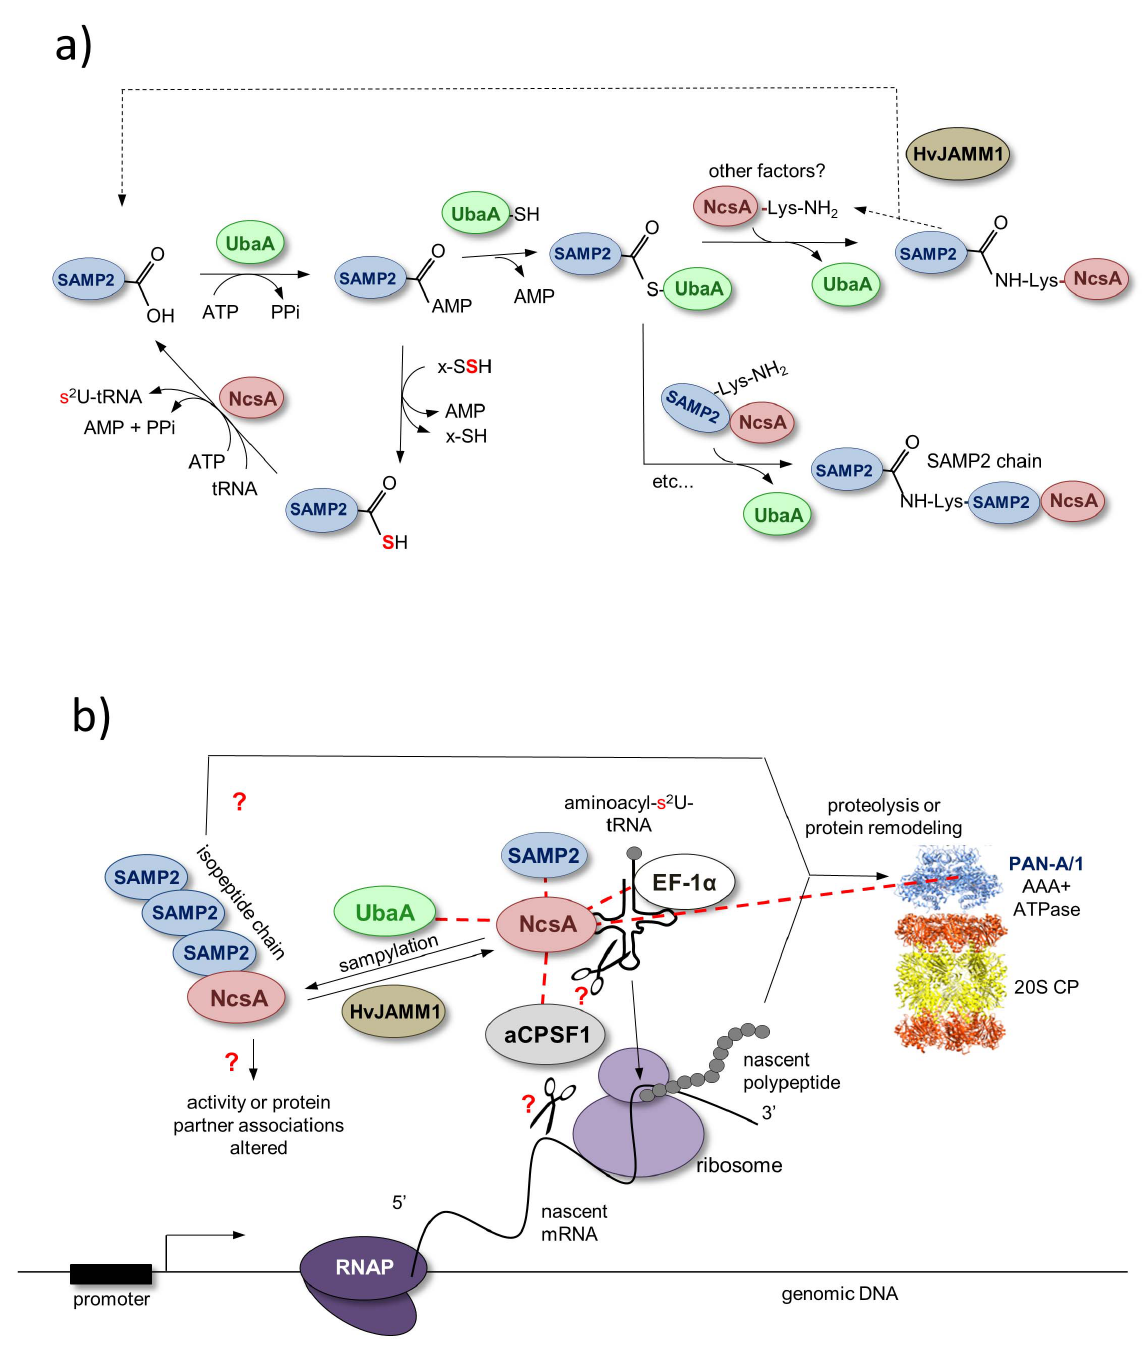
Figure 8. Model of NcsA activity and sampylation (panel A) as well as its association with protein partners (panel B). Panel A, NcsA is proposed to catalyze the formation of 2-thiouridine (s 2 U) at the wobble uridine position of tRNAs specific for lysine (tRNA Lys UUU ), glutamate (tRNA Glu UUC ), and glutamine (tRNA Gln UUG ) via an adenylated tRNA intermediate using thiocarboxylated SAMP2 as a source of activated sulfur. The E1- like UbaA adenylates the C-terminal a -carboxylate group of SAMP2. This modification readies the Ub-fold SAMP2 for either thiocarboxylation via an enzyme (cysteine desulfurase or rhodanese) catalyzed persulfide sulfur or protein modification via formation of a UbaA-SAMP2 thioester intermediate. Polymeric chains of SAMP2 are formed on an NcsA lysine residue via isopeptide linkages that are cleaved by HvJAMM1 protease. Whether additional factors are needed to provide specificity to the sampylation system is unclear, as E2 and E3 homologs are not predicted based on genome sequence. Panel B, NcsA is found isopeptide linked to SAMP2 and non-covalently associated with various proteins, as noted by dotted red lines. NcsA partners include the E1-like UbaA and Ub-fold SAMP2 of the tRNA thiolation and sampylation pathways. NcsA is also found associated with EF-1 a that binds aminoacylated-tRNAs and mediates translation elongation, PAN-A/1 (an AAA + ATPase associated with energy-dependent proteolysis by proteasomes (20S core particles or CPs) and protein remodeling, and the b -CASP ribonuclease homolog of the aCPSF1 family thought to cleave mRNA and/or tRNA. RNAP, RNA polymerase.